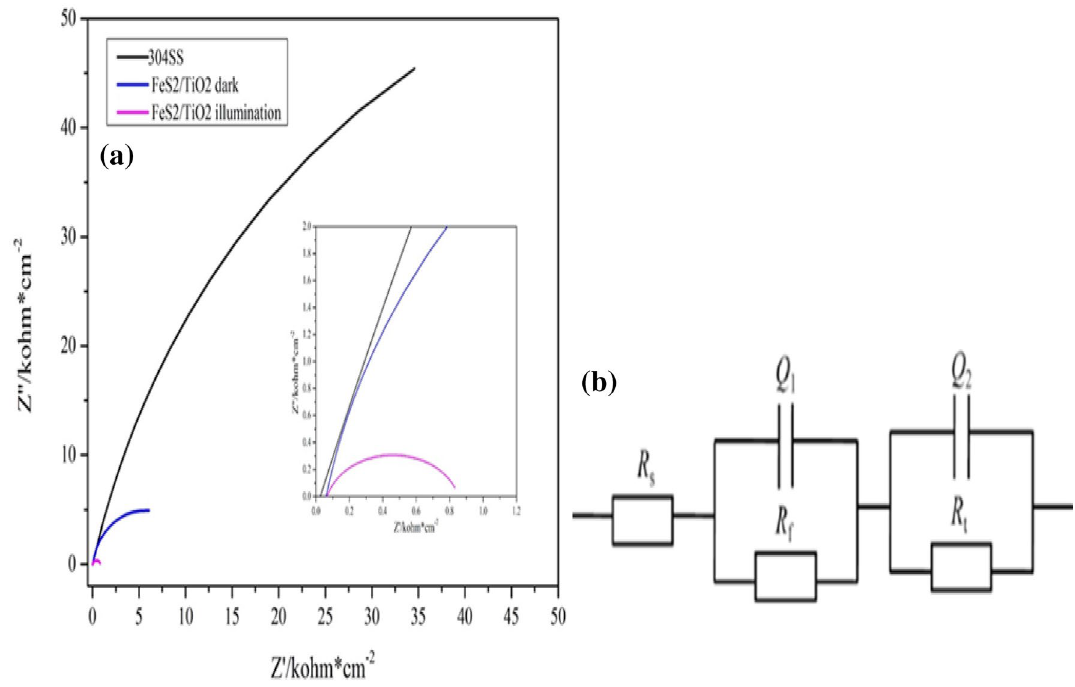
Figure 9. ( a ) Nyquist plots of 304SS, 304SS coupled with FeS 2 /TiO 2 under visible light illumination and dark state conditions ; ( b )The equivalent circuit model of FeS 2 /TiO 2 photoanode under